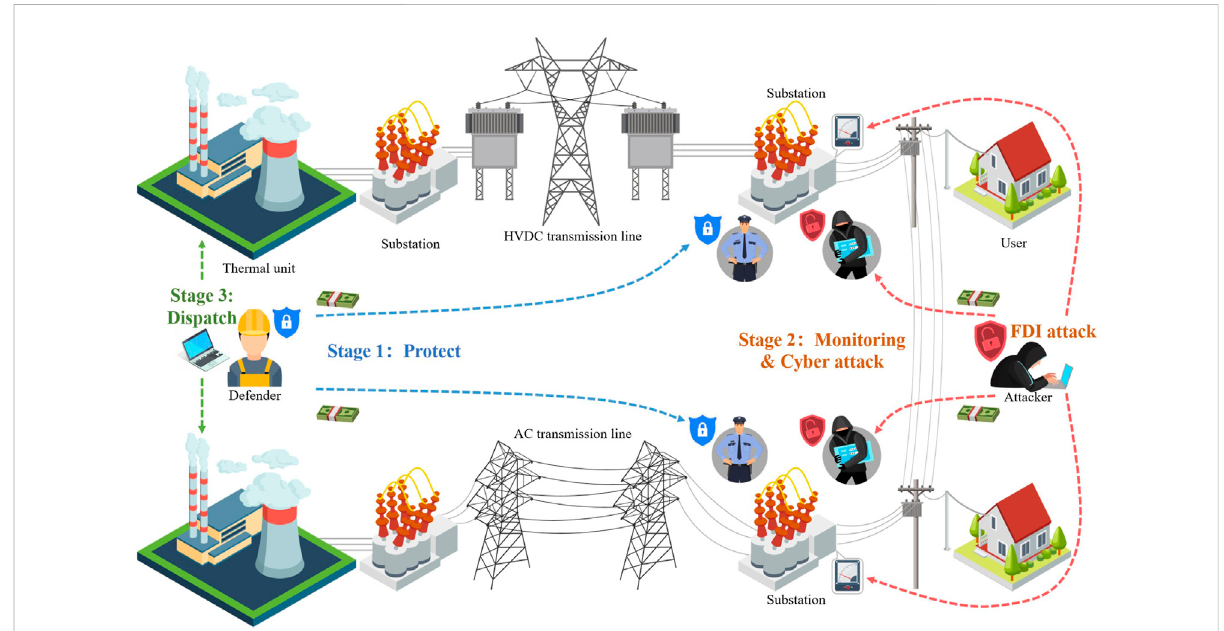
FIGURE 1 Illustration of three-stage physical-cyber attack and defense in an AC/DC hybrid transmission